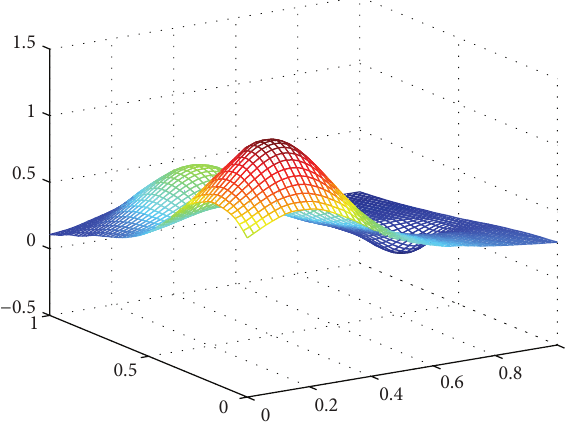
̃𝑄 (𝑥,𝑦) based on Figure 𝑓